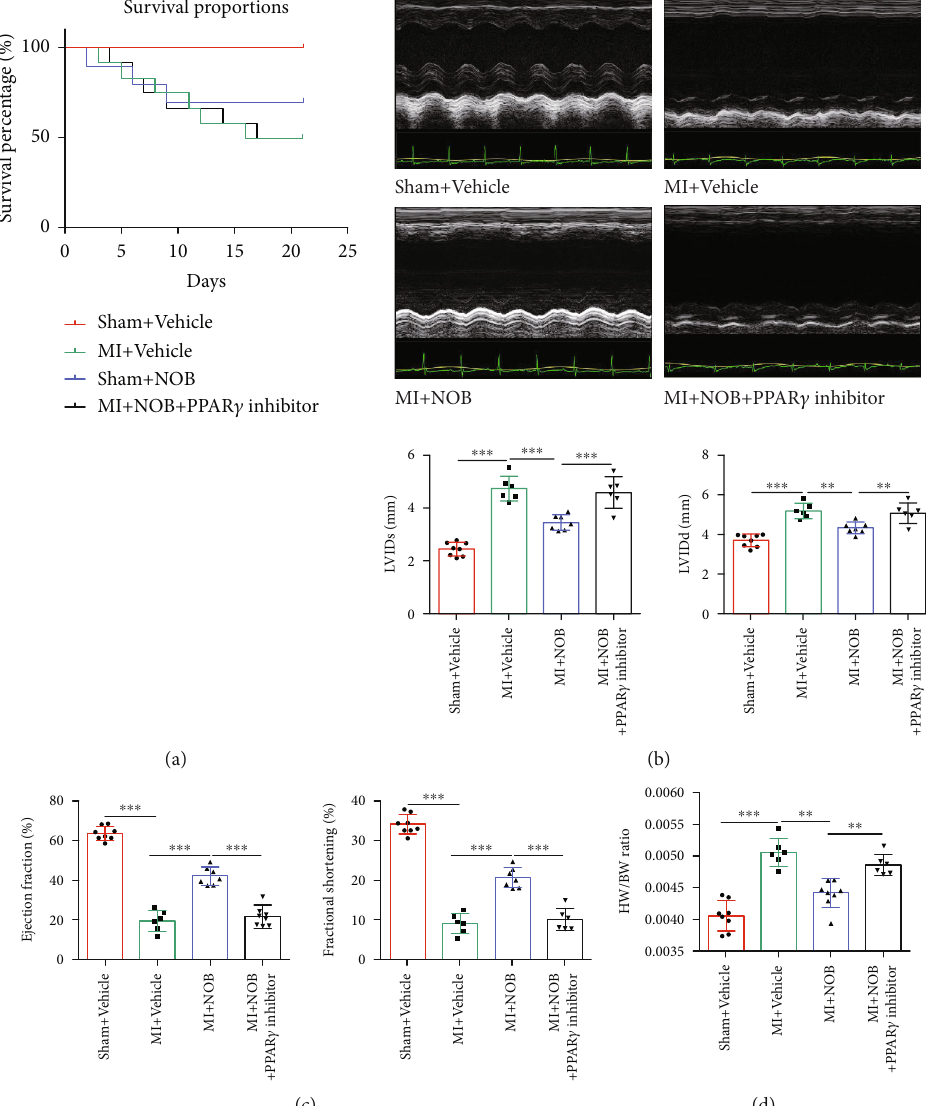
Figure 6: PPAR γ inhibitor (T0070907) reversed the protective e ff ects of NOB against chronic heart failure after MI. (a) The survival curve showed that the mortality rate of the PPAR γ inhibitor group was signi fi cantly higher than that of the NOB intervention group. The numbers of mice for the sham+vehicle, MI+vehicle, MI+NOB, and MI+NOB+PPAR γ inhibitor were 8, 12, 10, and 12 at the beginning of the experiment, whereas after 3 weeks, the numbers were 8, 6, 7, and 6, respectively. Six mice were sacri fi ced in the MI+vehicle and MI+NOB +PPAR γ inhibitor group, and four were sacri fi ced in the MI+NOB group. The survival rates for each group were 100%, 50%, 70%, and 50%. (b) Representative echocardiography images for all four groups ( n = 8 , 6, 7, and 6). (c) Parameters re fl ecting cardiac function showed reduced LVEF and LVFS and dilated LVIDd and LVIDs following PPAR γ inhibitor administration, revealing worsened cardiac function after PPAR γ inhibitor injection ( n = 8 , 6, 7, and 6). (d) The heart weight/body weight ratio increased in the inhibitor group ( n = 8 , 6, 7, and 6). Data are presented as mean ± SD . ∗∗ P < 0 : 01 ; ∗∗∗ P < 0 : 001 . PPAR γ : peroxisome proliferator-activated receptor gamma; NOB: nobiletin; MI: myocardial infarction; LVEF: left ventricular ejection fraction; LVFS: left ventricular fractional shortening; LVIDd: left ventricular internal diameter at end diastole; LVIDs: left ventricular internal diameter at end